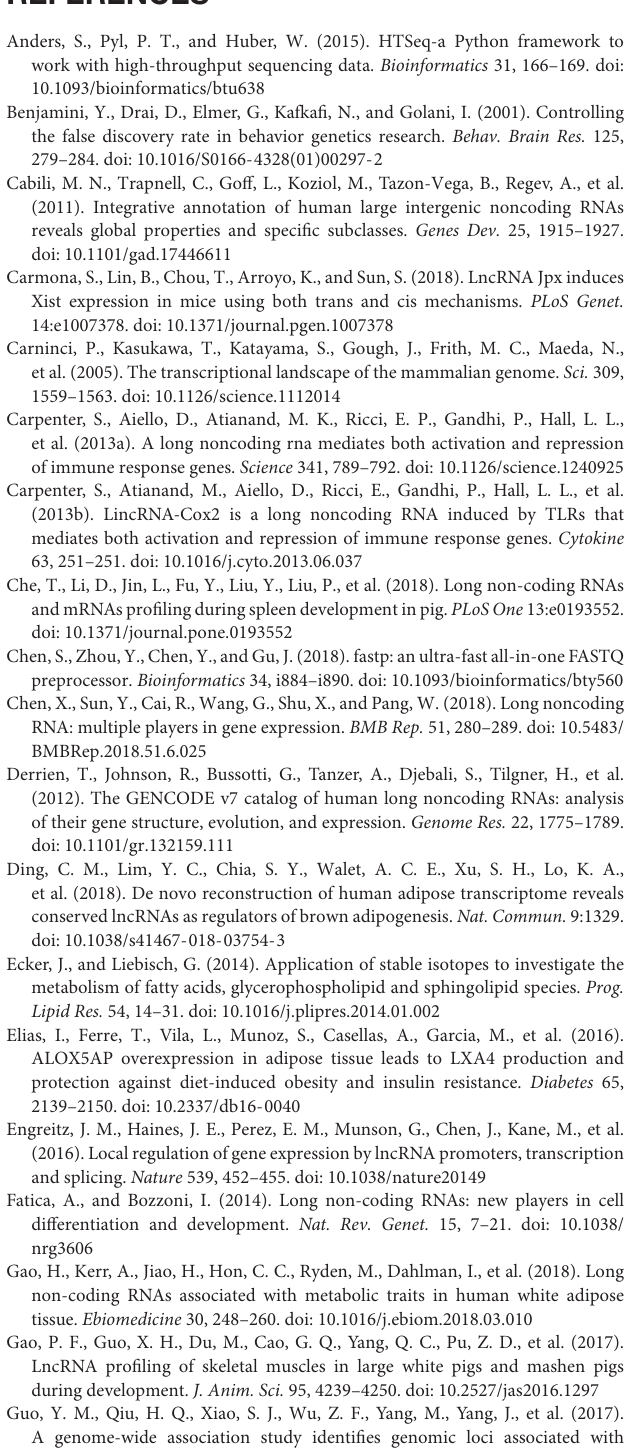
TABLE S2 | Gene ontology and pathway analysis of adjacent genes of lincRNAs. TABLE S3 | Quantitative trait locus mapping analysis on DELs.